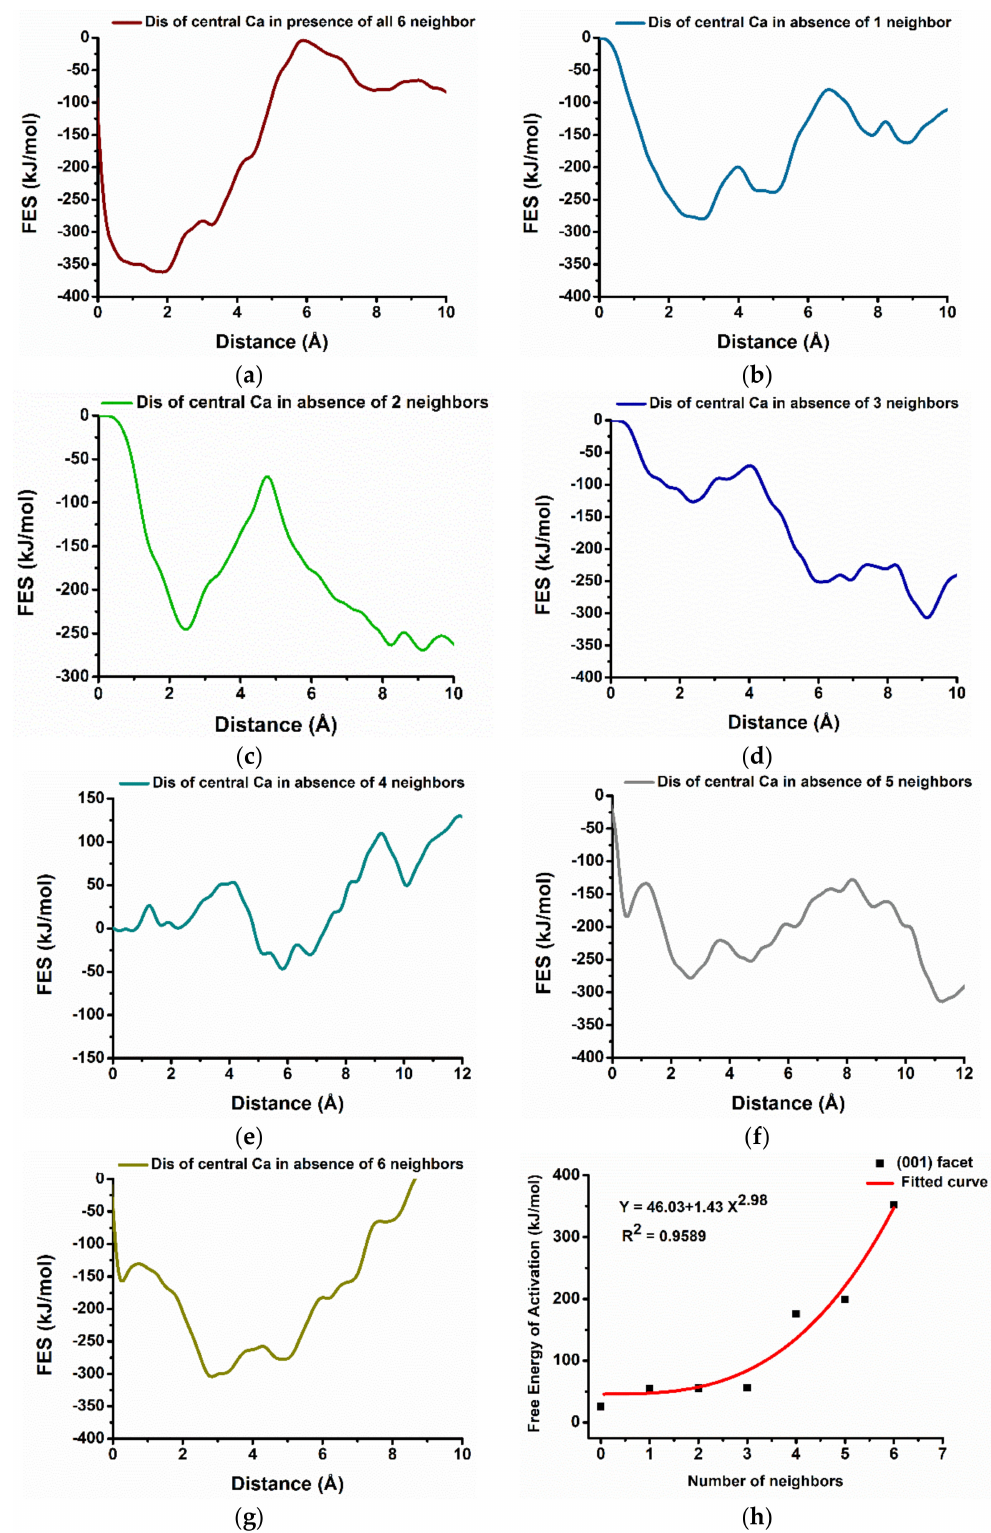
Figure 4. Representative dissolution profile (free energy surface) of the hexagonally oriented central Ca (red Ca in Figure 1) from (001) crystalline facet of Portlandite in different scenarios: the presence of all six Ca neighbors ( a ) and absence of the different number of 1,2,3,4,5,6 ( b – g ) hexagonally oriented neighbors. ( h ) The correlation diagram of free energy of activation of central Ca of (001) facet and hexagonally oriented number of Ca neighbors at 298